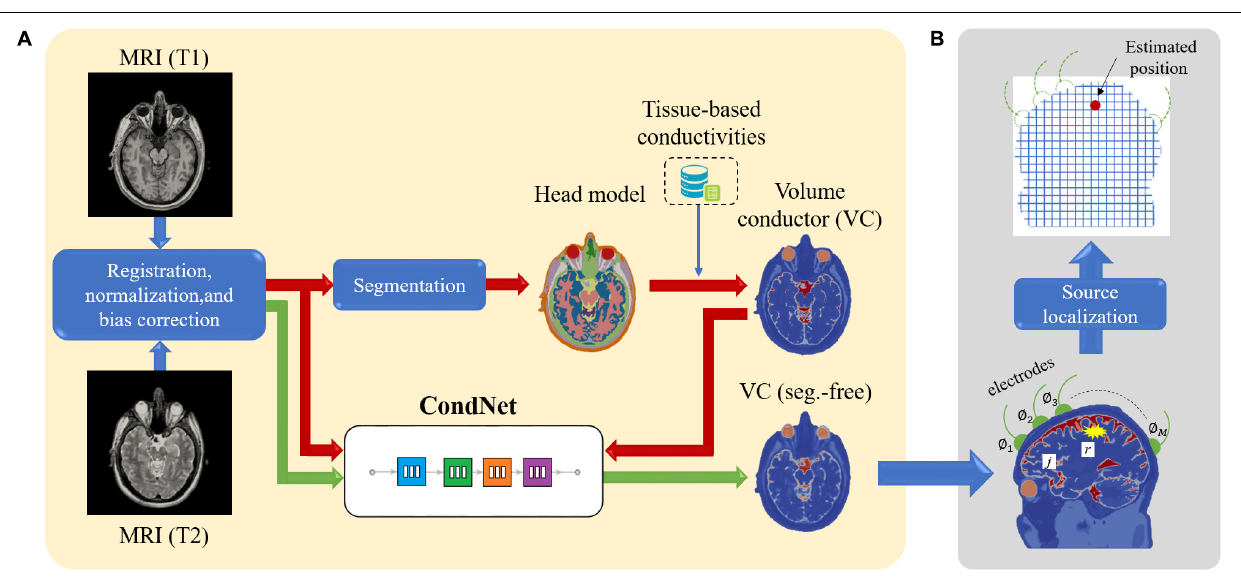
FIGURE 2 | (A) Procedure for constructing segmentation-free head model using deep learning network (CondNet). (B) System model for EEG source